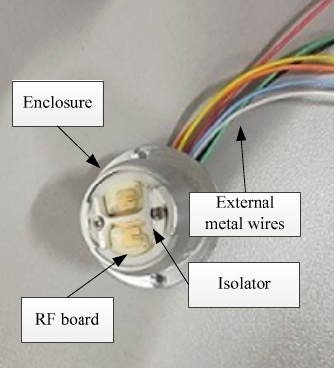
Figure 3. The external structure of the radar.